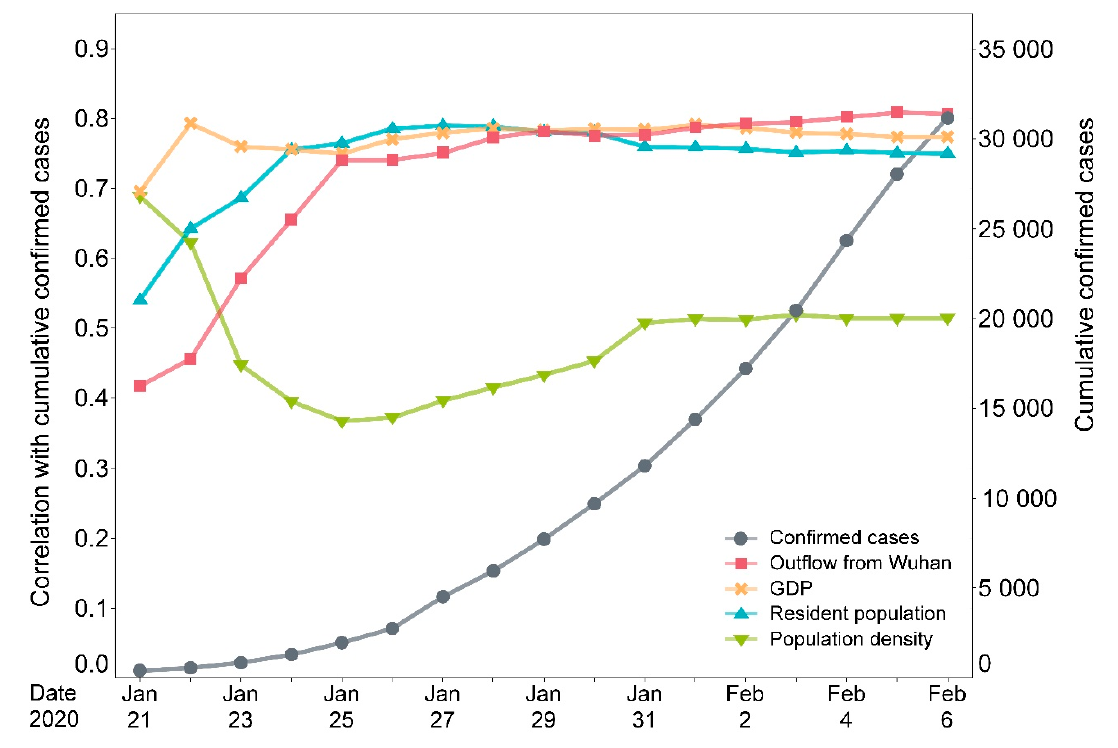
Figure 6. The correlations between socioeconomic variables and cumulative confirmed cases according to Pearson coefficients.